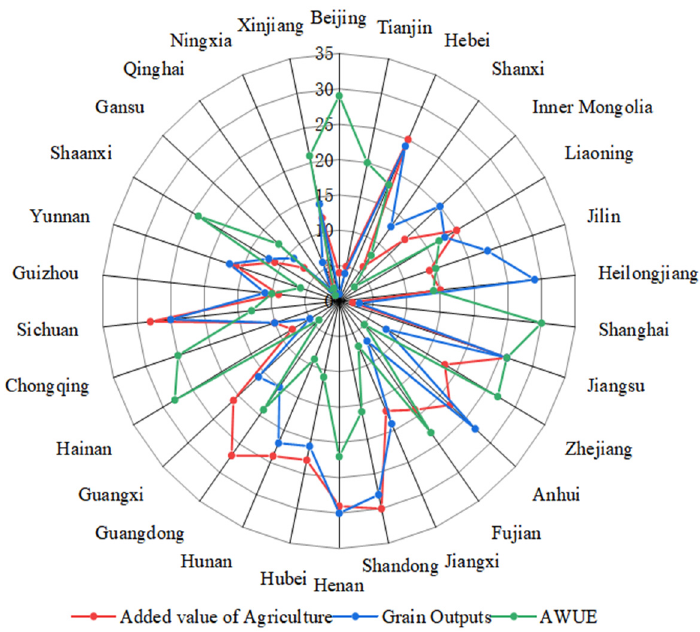
Figure 11. Ranking of average value of added value of agriculture, grain outputs, and AWUE (agricultural water use efficiency) in China from 2000 to 2019. (For comparison and display purposes, the highest value rank is 30, and the lowest value rank is 1.).